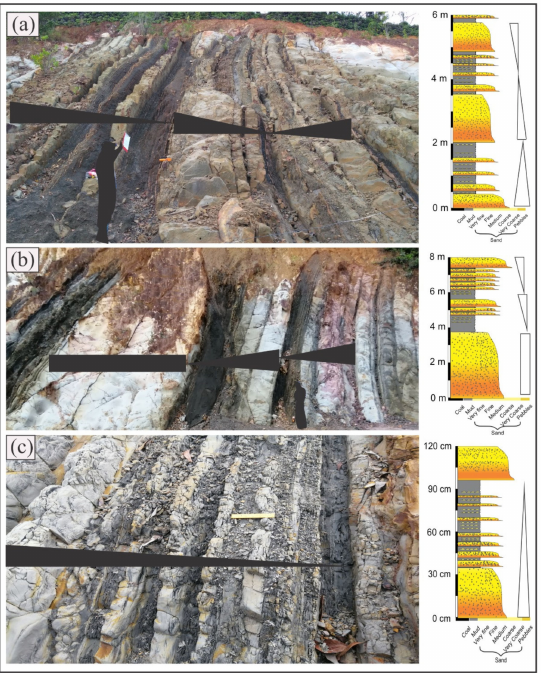
Figure 9. Thinning and thickening patterns ( a ) marked by three cycles—two thinning and one thickening—each of about a 2 m vertical thickness in the Jalan UMS behind KFC outcrop. ( b ) Massive sand unit overlain by two thickening trends in the Jalan UMS behind KFC outcrop. ( c ) One cycle of thinning with a vertical thickness of only 1 m in the Jalan Sulaman